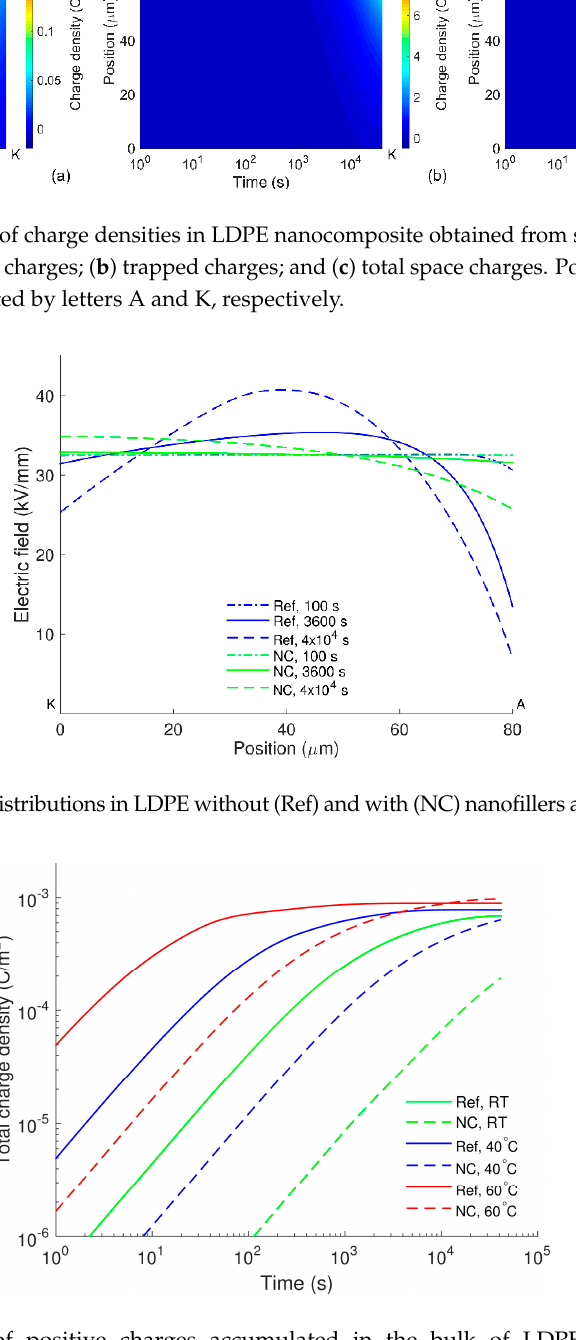
Figure 7. Amount of positive charges accumulated in the bulk of LDPE (Ref) and LDPE nanocomposite (NC).